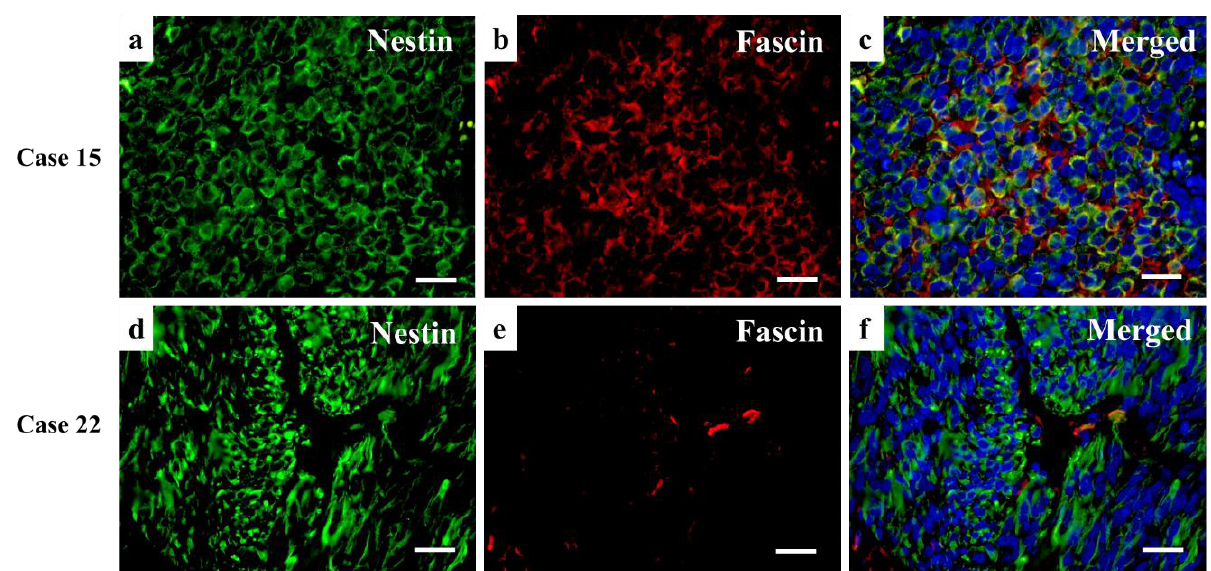
Figure 6. Double immunofluorescence staining images of Case 15 and 22. ( a – c ) Immunofluorescence staining of Nestin, Fascin, and the merged staining of the two proteins in the primary tumor of Case 11. A 71-year-old woman was diagnosed with nasal cavity melanoma in September 2015 and had surgical treatment. At the margin of the resected tissue, it was not obvious if tumor cells were removed completely or not, therefore, she had 60 gray radiotherapy. However, in February 2016, distant metastasis was detected. Allred scores of Nestin and Fascin were +8 and +8, respectively, at the primary lesion. Both Nestin and Fascin positive cells densely exist in the tumor. ( d – f ) Immunoflu- orescence staining of Nestin, Fascin, and the merged staining of the two proteins in the primary tumor of Case 22. A 79-year-old man was diagnosed with melanoma on the cheek, and surgical treatment was performed in September 2016. The tumor cells at the margin of the resected tissues were not clearly negative, and topical chemotherapy was planned, which was not undertaken due to patient personal reasons. In May 2018, multiple metastases at the lung and brain were detected. Allred scores of Nestin and Fascin were +8 and 0, respectively, at the primary lesion. Nestin-positive cells are observed at the large area of the tumor, but Fascin is positive only in the vascular endothelial cells. (Scale bars: 50 µ